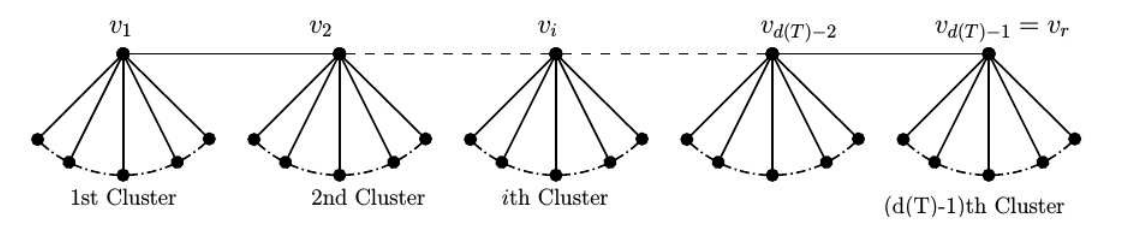
Figure 2: A dense